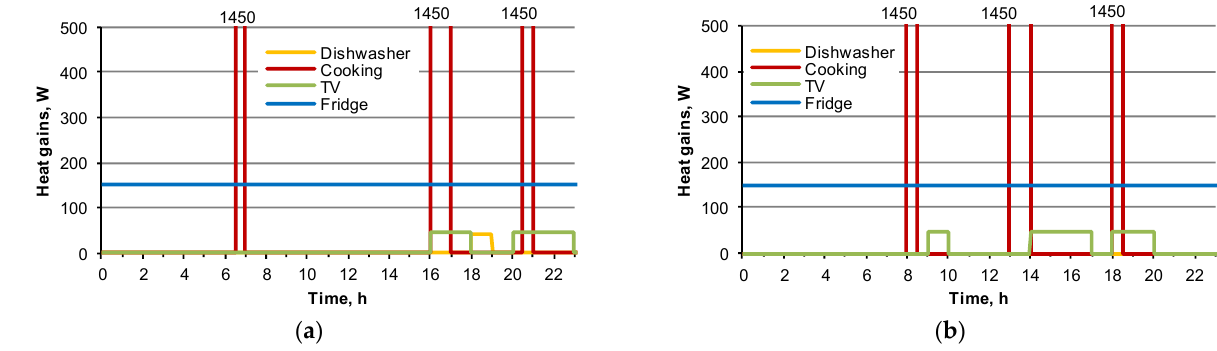
Figure 5. Heat gain from the equipment in the living-room: weekdays ( a ) and weekend ( b ).